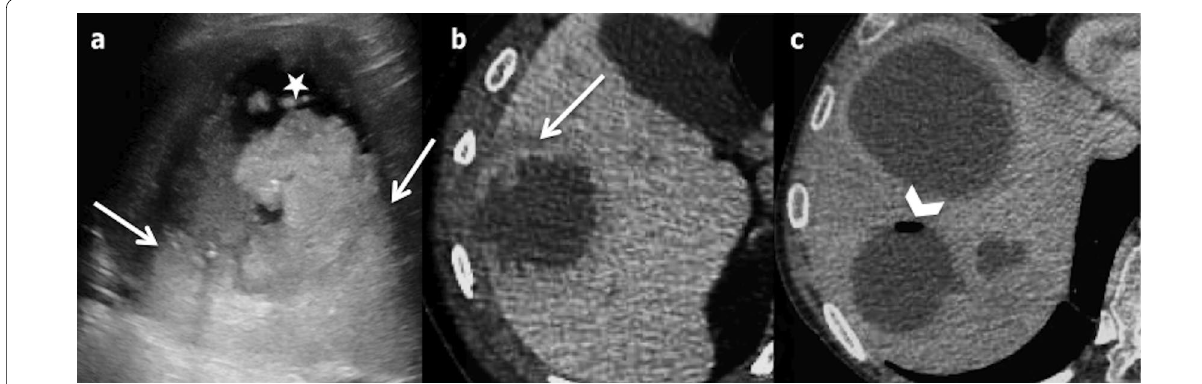
Fig. 27 Hepatic pyogenic abscesses in a 49-year-old male. a Ultrasonography shows a large heterogeneous hypoechoic lesion, with anechoic parts (star) and increased through transmission (arrows) confirming its cystic nature. b and c Axial computed tomography on portal venous phase displays multiple abscesses appearing as cystic masses, with a specific sign: the double target (arrows). Note the bubble of gas in one of them